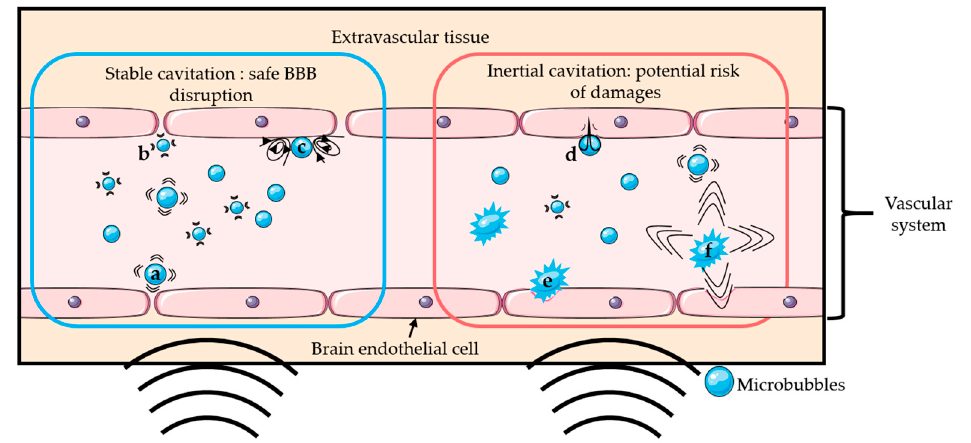
Figure 1. Schematic representation of several mechanisms of BBB disruption: Stable cavitation induces push- ( a ) and-pull ( b ) mechanism and microstreaming ( c ), which can permeabilize the blood-brain barrier safely. Inertial cavitation induces micro-jetting ( d ), fragmentation ( e ), and shock-wave ( f ) that can permeabilize the BBB with risks of damages.